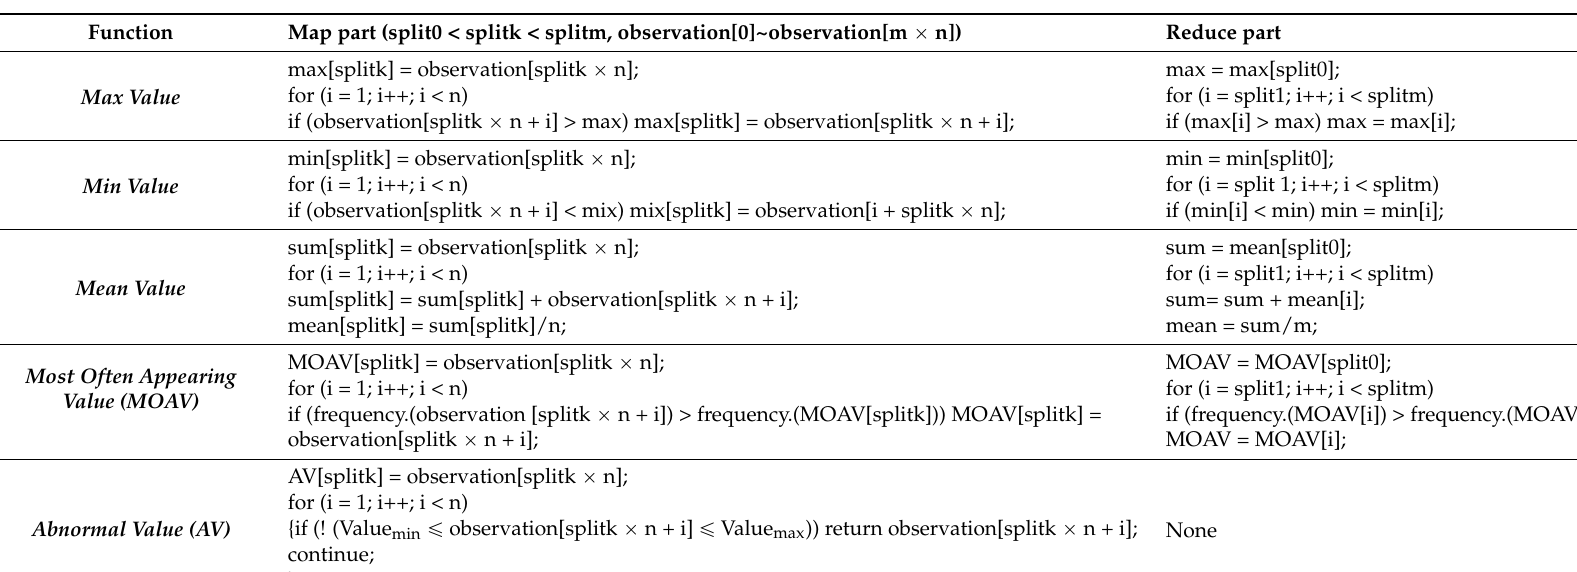
Table 1. Case design of the statistical analysis in the map/reduce